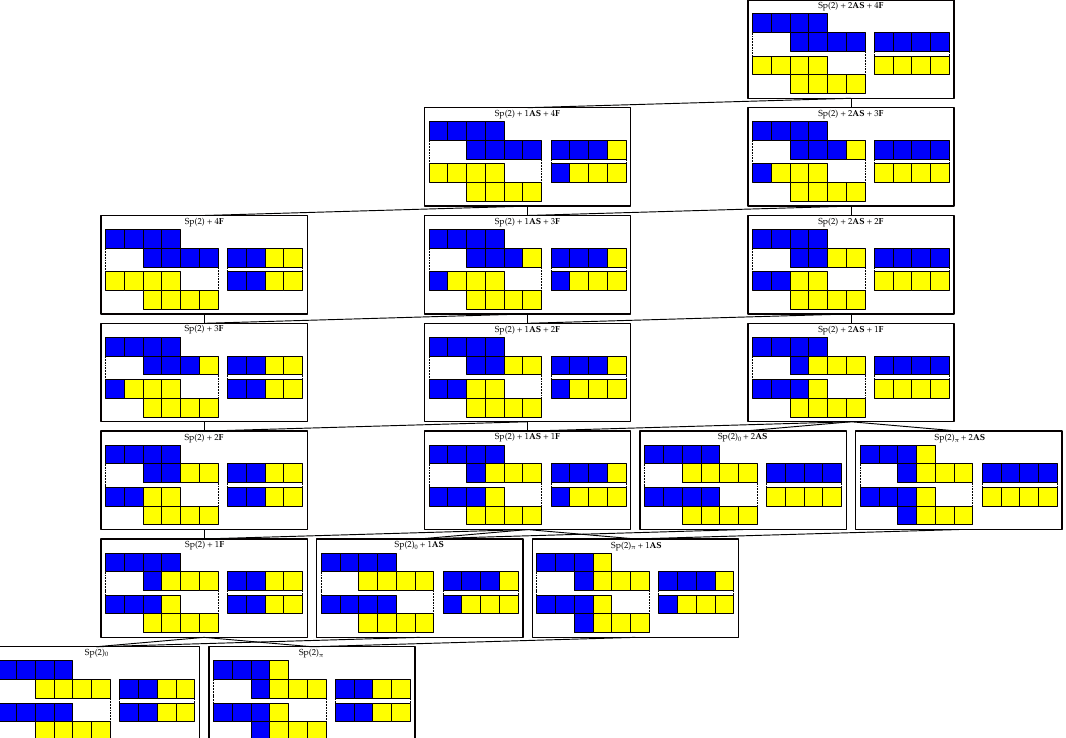
Figure 37. The tree of descendants for Sp(2) + 6 F + 2 AS , which is gauge theory description for the marginal theory obtained from SU(3) on a ( (cid:0) 1)-curve with 12 hypermultiplets.